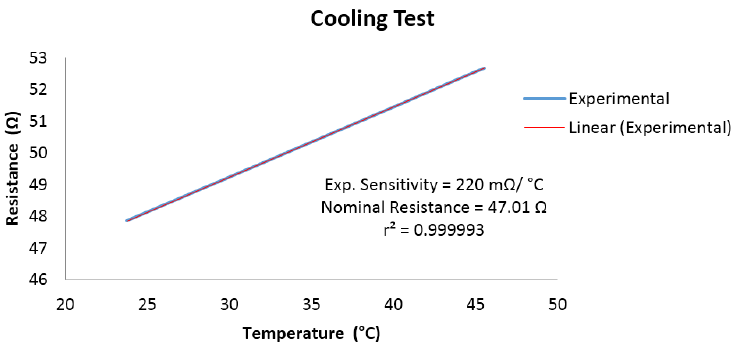
Figure 10. Experimental and fitted TR curves (Heating, N10046S1). Fibers 2016 , 4 , 29